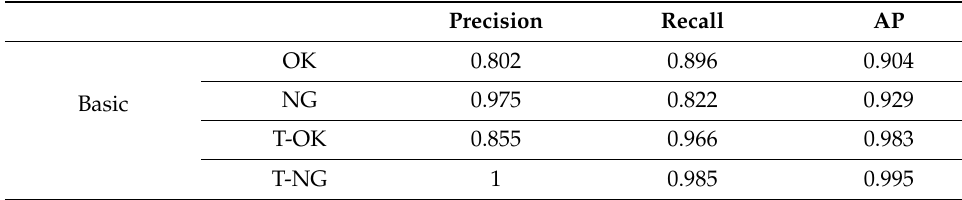
Table 6. SSIM results (grid size).